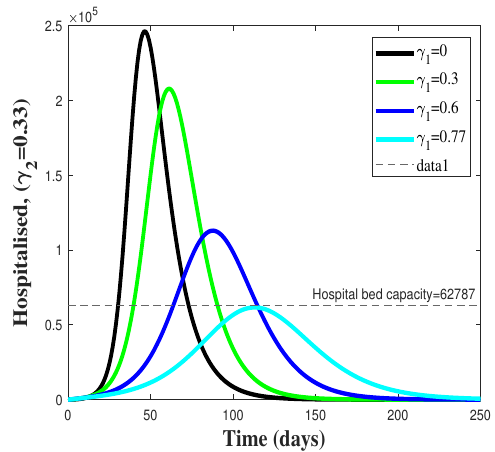
Fig. 13: Population level plots for hospitalized individuals for varying values of γ 1